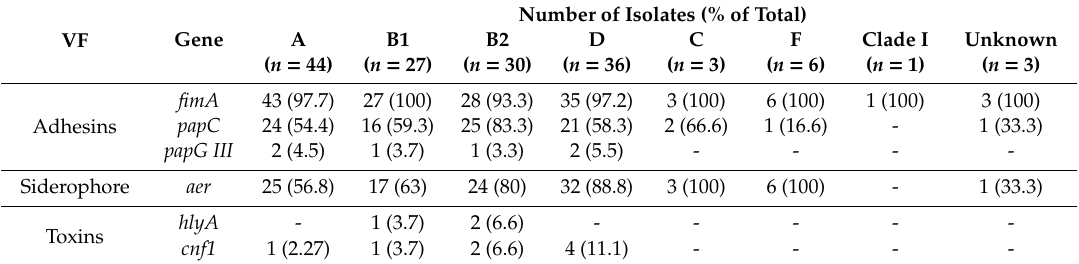
Table 4. Conjugation frequencies of ESBL-producing E. coli according to their origin.